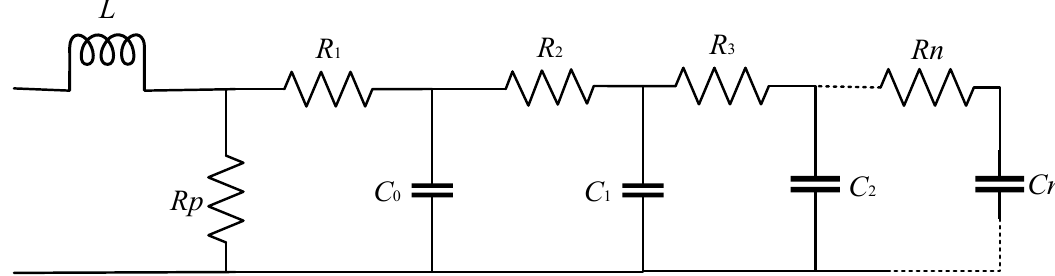
Figure 10. Transmission line model of DLCs.